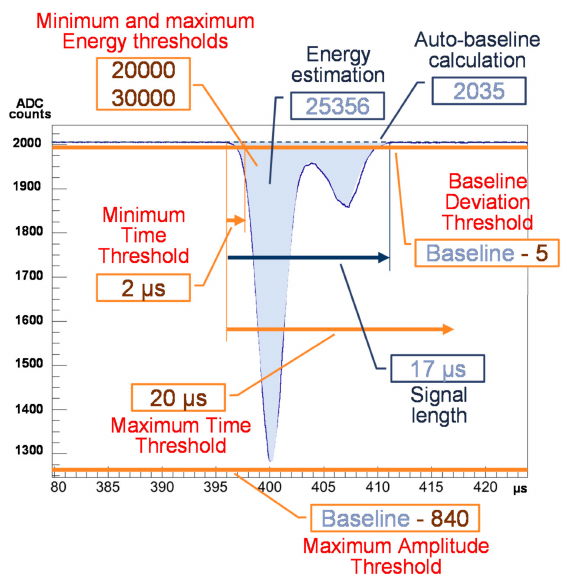
Figure 5. Example of signal candidate generation. In red, the complete set of configuration parameters to generate an event candidate from a PMT signal. In blue, data estimated by the event processor over the reconstructed signal by the BLR